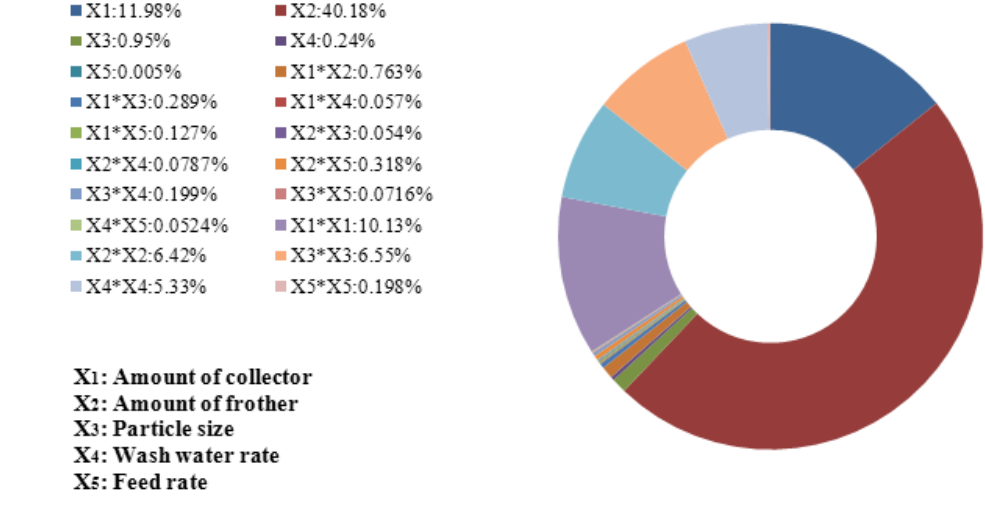
Fig. 3. Linear, interactive and quadratic effect of process variables on pyrite sulphur removal from